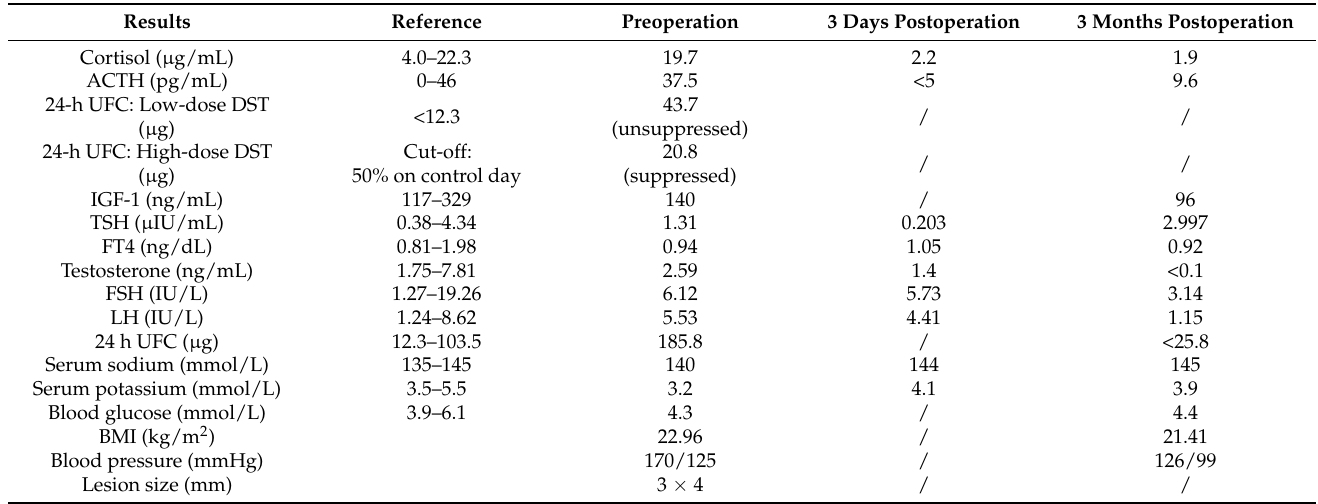
Table 2. Clinical characteristics of case 2